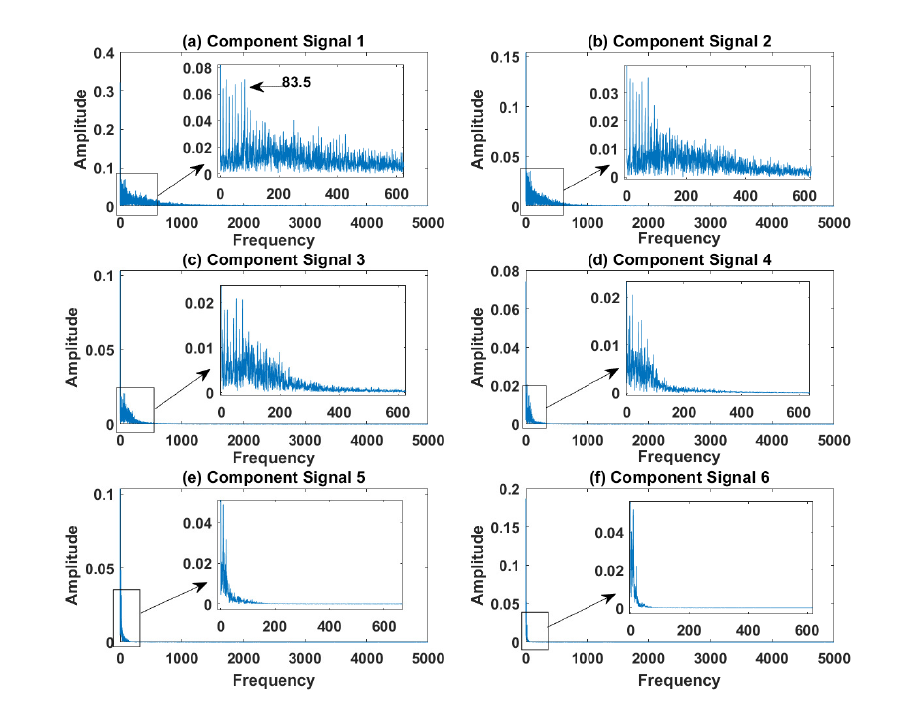
Figure 14. Decomposition results of EMD with m = 16: ( a – f ) envelop of 1st to 6th subcomponents, respectively.